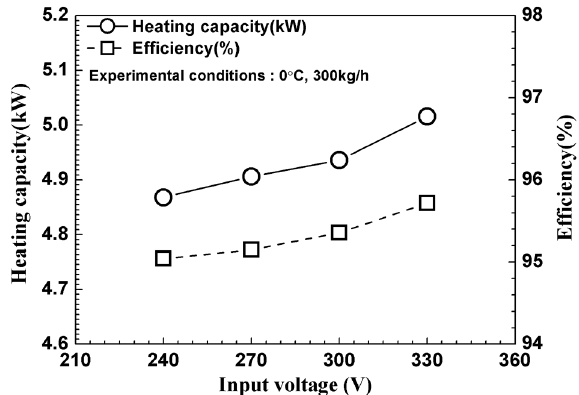
Figure 6. Variation of heating capacity and efficiency.